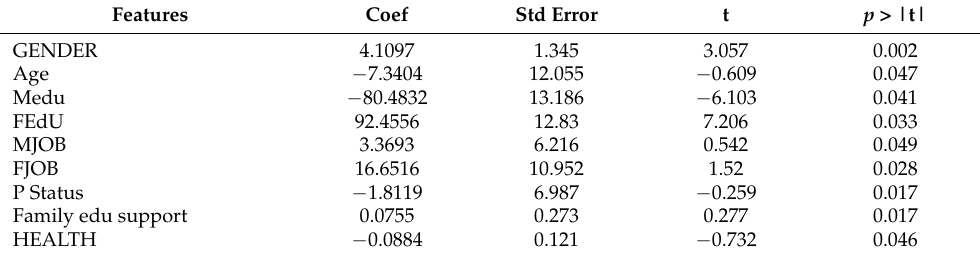
Table 3. Final OLS summary.